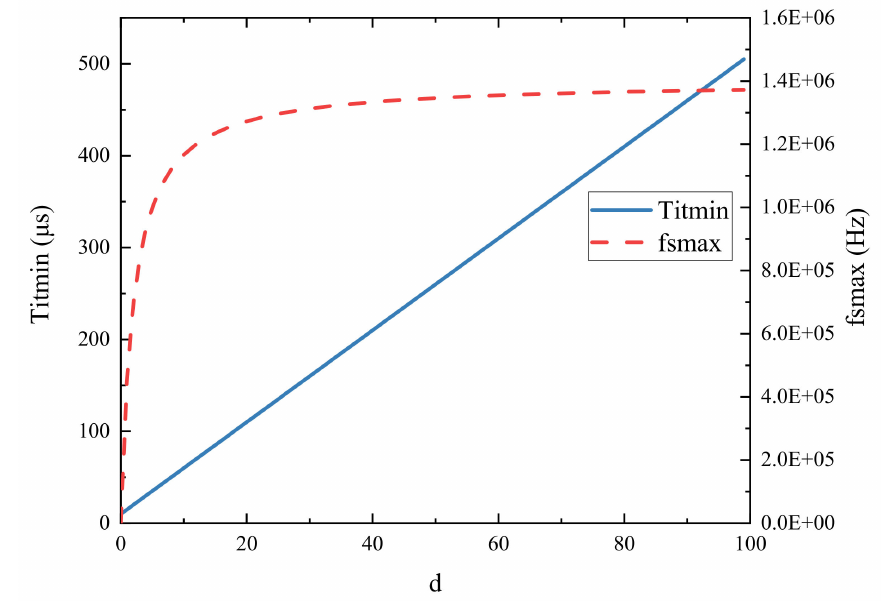
Figure 8. Relationship between T it min , f s max and d